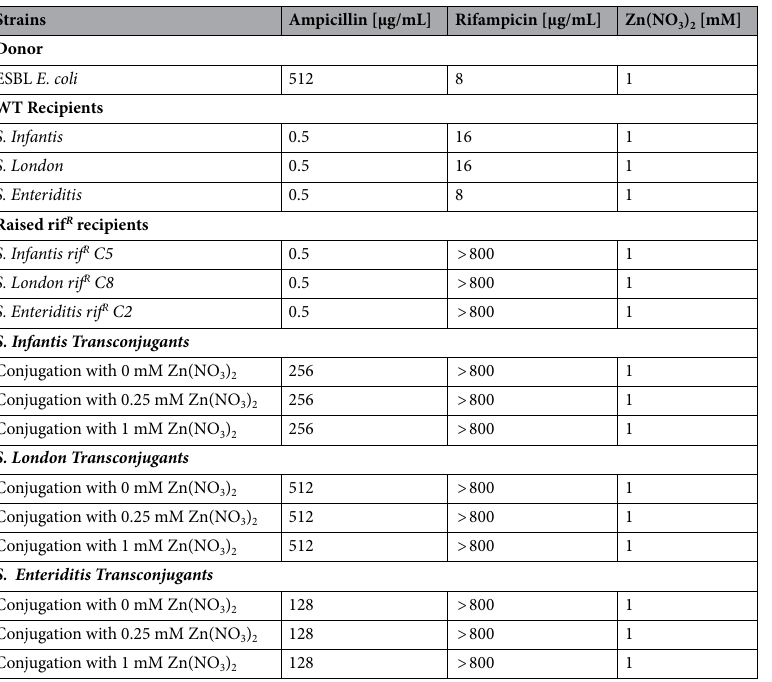
Table 1. Antimicrobial resistance profiles identified via MIC testing of donor, recipients, and